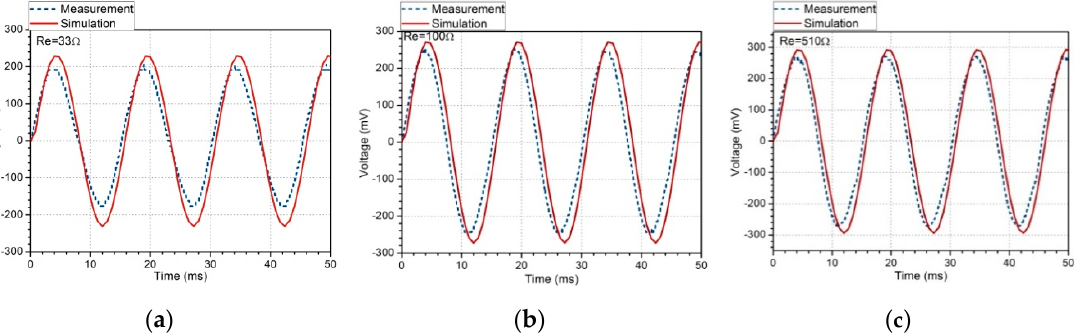
Figure 10. Comparison between numerical and experimental output voltage on external resistor. ( a )